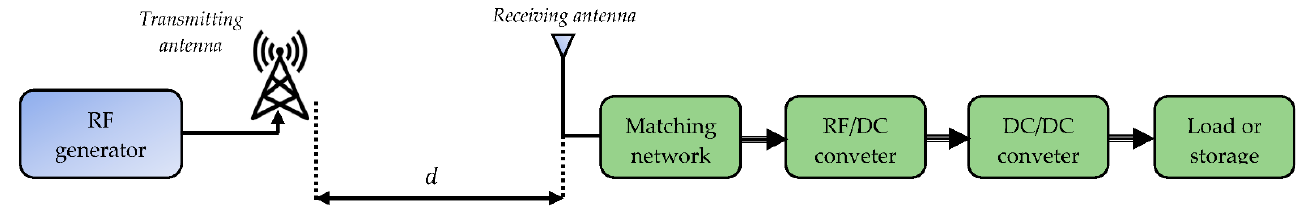
Figure 2. Far-field WPT and RF/DC conversion blocks of an RF-EH system.